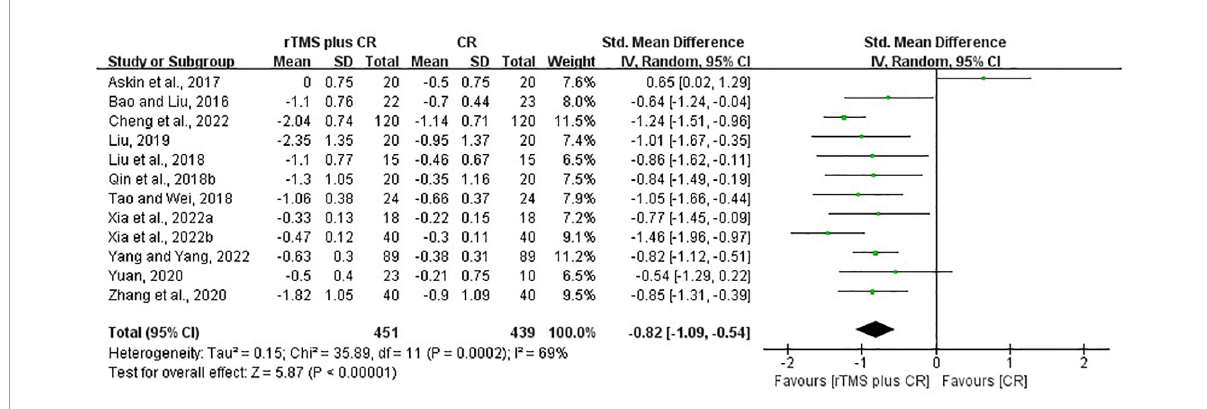
FIGURE5 The forest plot of MAS in comparison of rTMS plus CR versus CR.